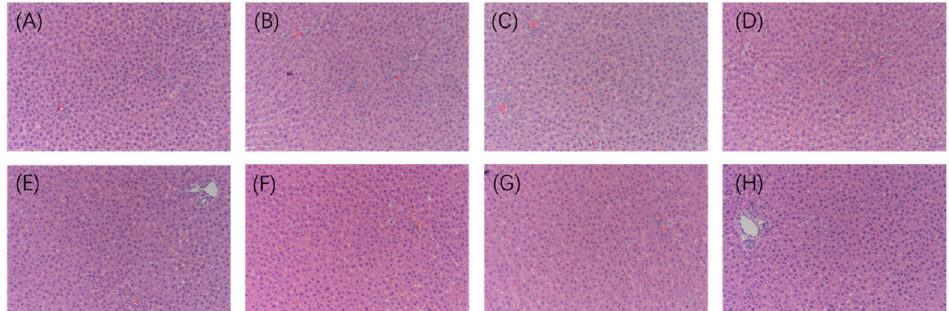
Figure 9. Histopathological analysis of liver tissue. ( A ) RC, ( B ) SC, ( C ) PD, ( D ) LL, ( E ) HL, ( F ) LET, ( G ) MET, and ( H ) HET. N = 3, Magnification ×200.